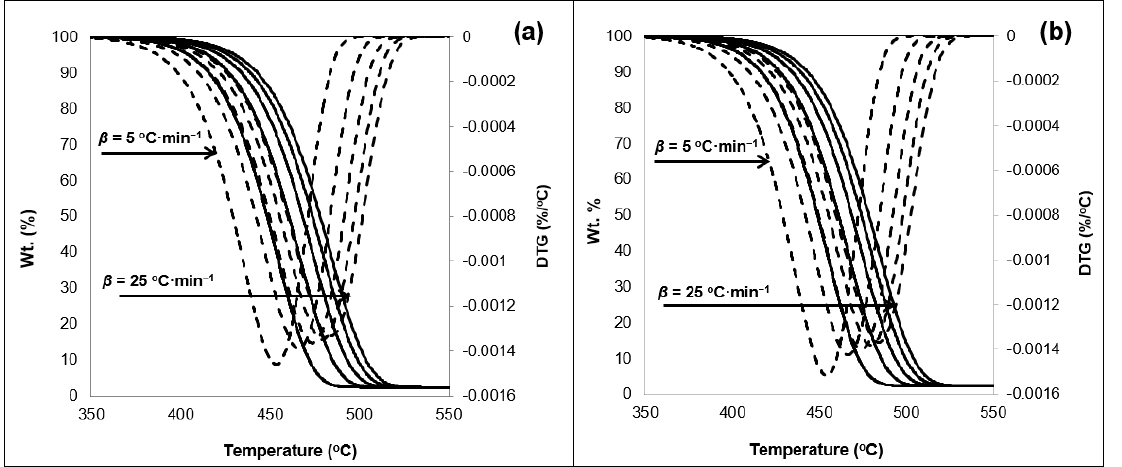
Figure 3. TGA thermogram showing weight loss ( ─ ) and first derivative (- - -) of the 0/100 sample ( a ) pre-exposure and ( b ) exposed to 11 days in N 2 atmosphere with respect to heating rates (5 to 25 °C·min − 1 ) in sequential order.